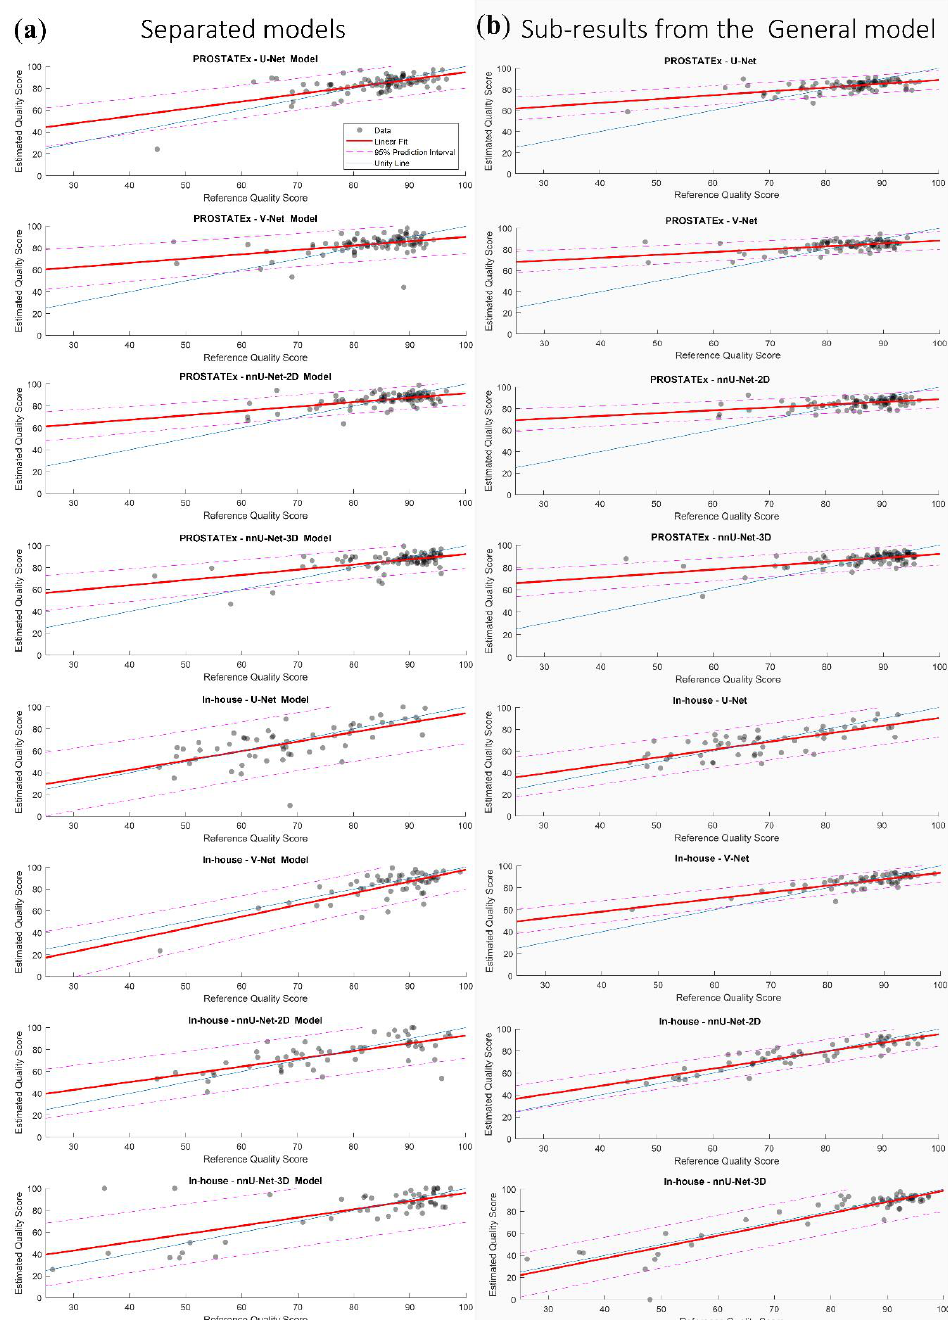
Figure 7. The linear fit of the estimated quality scores with 95% prediction interval of the eight non- generalizable models ( a ) and the sub-results from the General model ( b